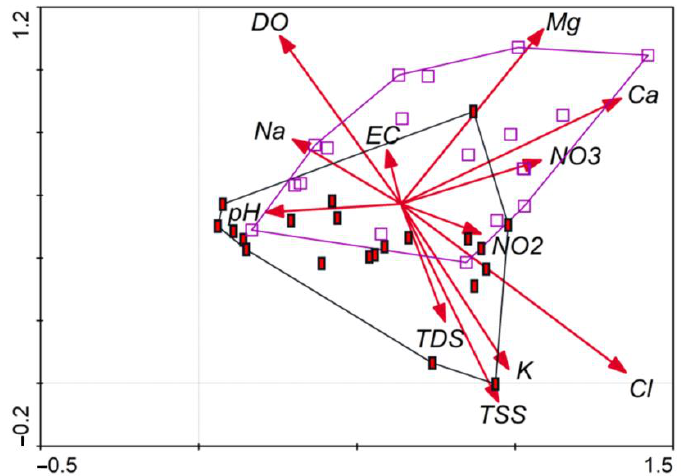
Figure 15. CCA plot with eigenvectors designated factors affecting physicochemical parameters in rainwater. Open squares show urban area. Red squares represent rural area.